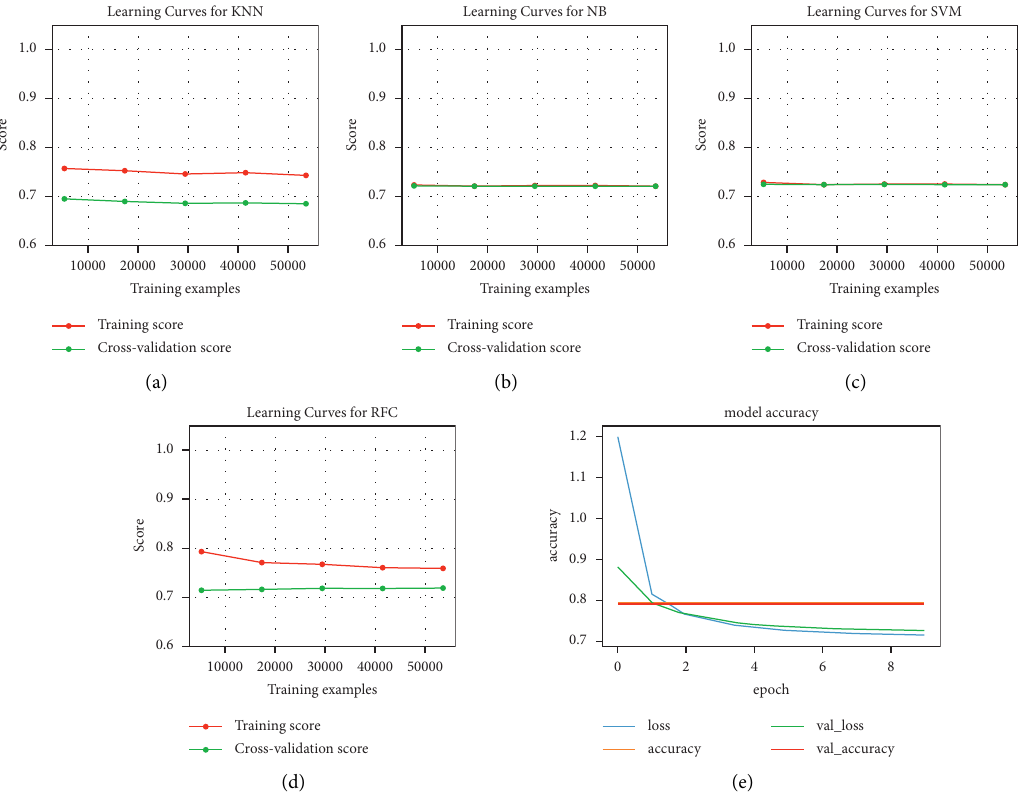
Figure 4: Learning curves for different models. (a) KNN. (b) NB. (c) SVM. (d) RF. (e) DNN.